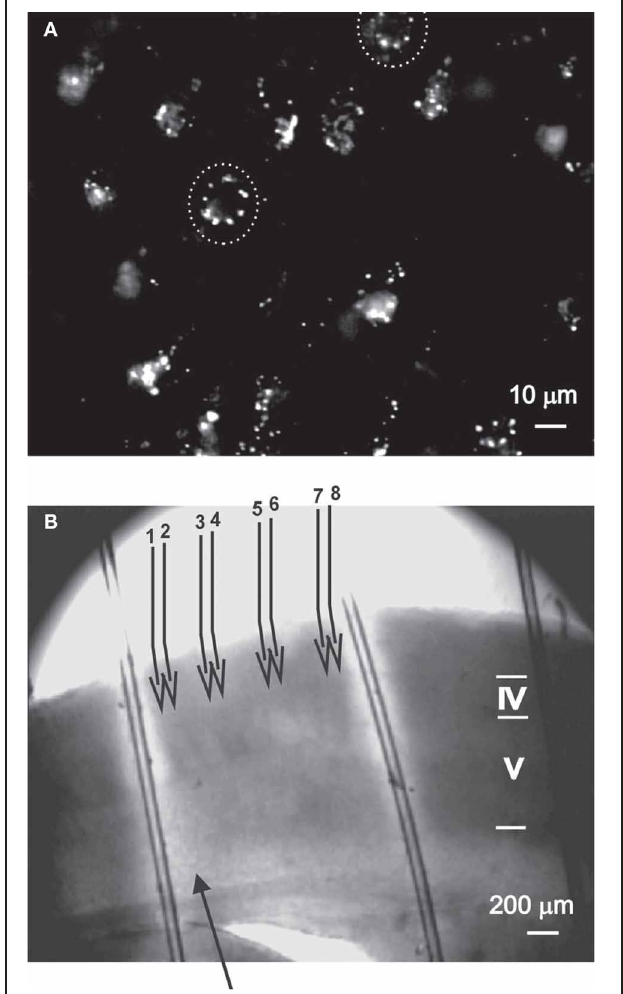
FIGURE 1 | The experimental methods used to evaluate the role of nNOS + neurons. (A) DAF-2DA staining of neurons in acute slices, as visualized under the 40 × objective (details in Buskila et al., 2005). Suspected neuronal somata are surrounded by dashed circle. (B) The illustration depicts the experimental paradigm. An acute slice which had been incubated in DAF-2DA is illuminated through the 4 × objective (Methods, area displayed in bright light). The stimulating electrode (filled arrow) is placed above the white matter. For LFP recordings, four pairs of micropipettes (numbered open arrows) are placed in layer 2/3, where electrode #1 is in column with the stimulating electrode. Cortical lamina is marked by roman